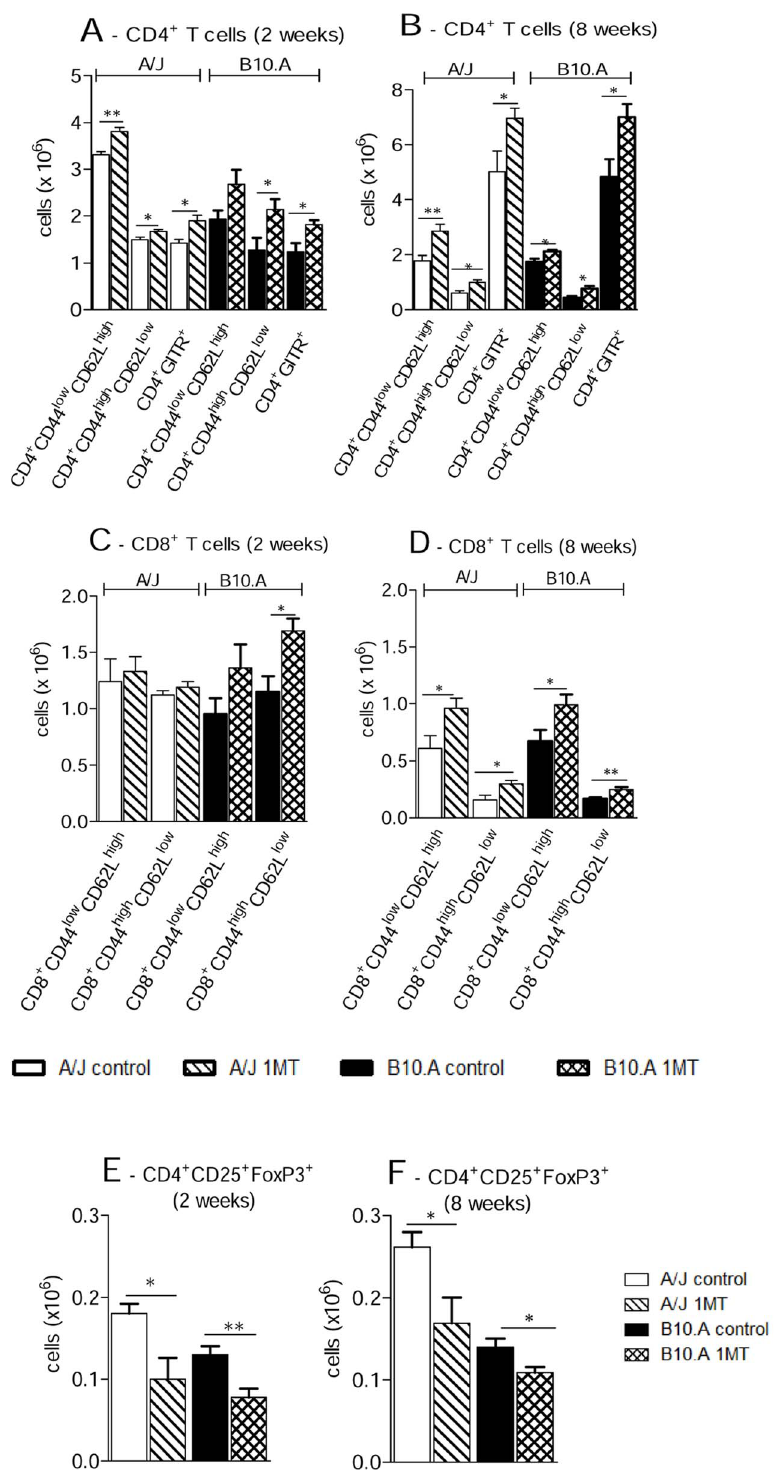
Figure 6. IDO inhibition increases the migration of naı¨ve and effector/memory CD4 + and CD8 + T cells to the lungs of A/J and B10.A mice, but reduces the number of regulatory T cells. ( A, B, C, D ) Characterization of CD4 + , CD8 + T cells by flow cytometry in the lung infiltrating leucocytes (LIL) from 1MT treated and untreated A/J and B10.A mice inoculated i.t. with 1 6 10 6 P. brasiliensis yeast cells. At weeks 2 and 8 after infection, lung cell suspensions were obtained and stained as described in Materials and Methods. The acquisition and analysis gates were restricted to lymphocytes. The total numbers of effector (CD44 high CD62L low ) and naı¨ve (CD44 low CD62L high ) CD4 + and CD8 + T cells at weeks 2 and 8 after infection were determined. ( E, F ) To characterize the number of Treg cells in LIL at weeks 2 and 8 weeks of infection, cells positive for surface staining of CD25 and intracellular Foxp3 expression were back-gated on the CD4 + T cell population. The data represent the means 6 SEM of 6–8 mice per group and are representative of three independent experiments (* p , 0.05 and ** p , 0.01). doi:10.1371/journal.pntd.0003330.g006 PLOS Neglected Tropical Diseases |